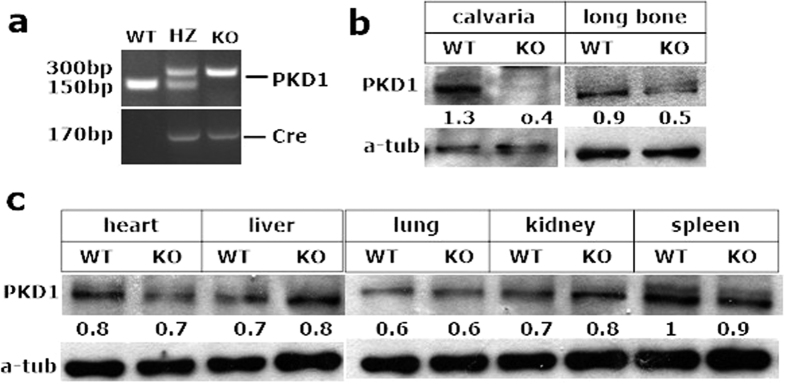
PKD1 was deleted specifically in transgenic mice.(a) Representative genotyping PCR for PKD1 floxed and cre transgene relative to wild type PKD1. The genome of littermates knockout (KO) carried two copy of PKD1floxed and one copy of the OSX-Cre gene (Osx::PKD1fl/fl mice), the genome of littermates heterozygou (HZ) carried one copy of PKD1 floxed and the OSX-Cre gene (Osx-Cre::PKD1fl/+), and the genome of cre-null littermates control only carried PKD1floxed gene (wild type control, WT). (b) Representative Western blotting for the expression of PKD1 and internal control of alpha tubulin (α -tub) in calvariae and long bone derived from 4-week-old KO or WT mice. Uncropped western blot images corresponding to Fig. 1(b,c) were shown in supplementary information file. Tissues were pooled from WT or KO mice (n = 3); experiments were repeated twice using mice from different litters. (c) Western blotting for the expression of PKD1 and internal control ofα-tub in heart, liver, kidney, lung and spleen from the same age WT or KO mice. All Band densities of PKD1were normalized to α-tublin content within each sample.